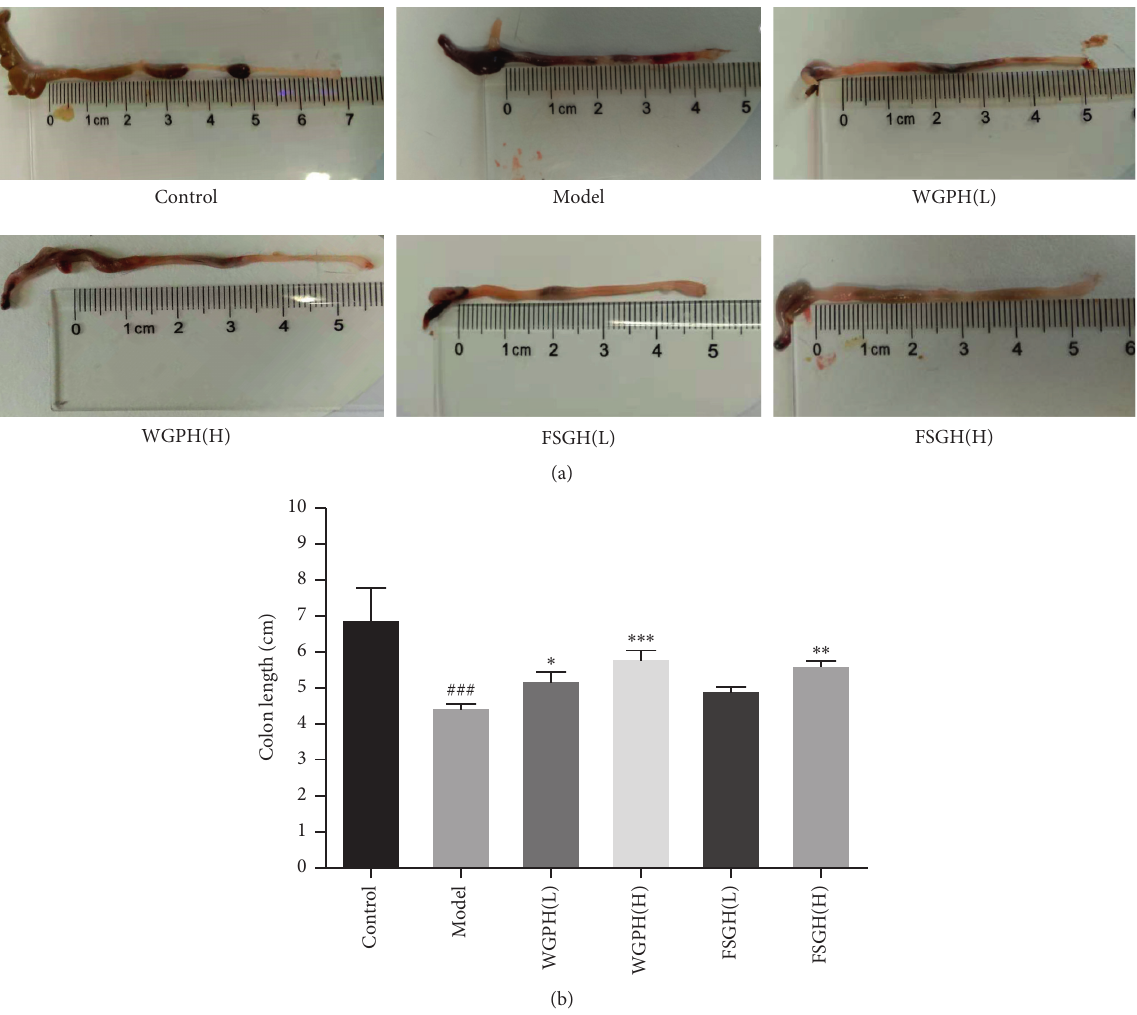
Figure 1: Protease hydrolysates could alleviate the symptoms of DSS-induced UC mice. (a) Protease hydrolysates validly improved the shorten of the colon tissue. (b) Quantitative results of colon length in different groups. ### P < 0 . 001 vs. control; ∗ P < 0 . 05, ∗∗ P < 0 . 01, and ∗∗∗ P < 0 . 001 vs.